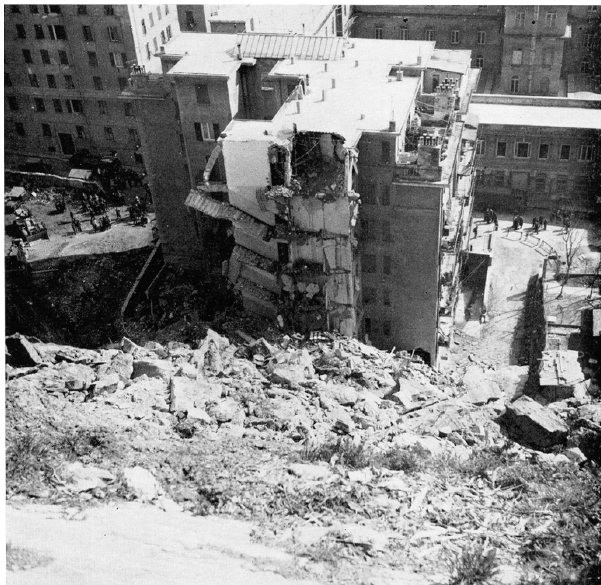
Fig. 9. Via Digione landslide (from Peretti,